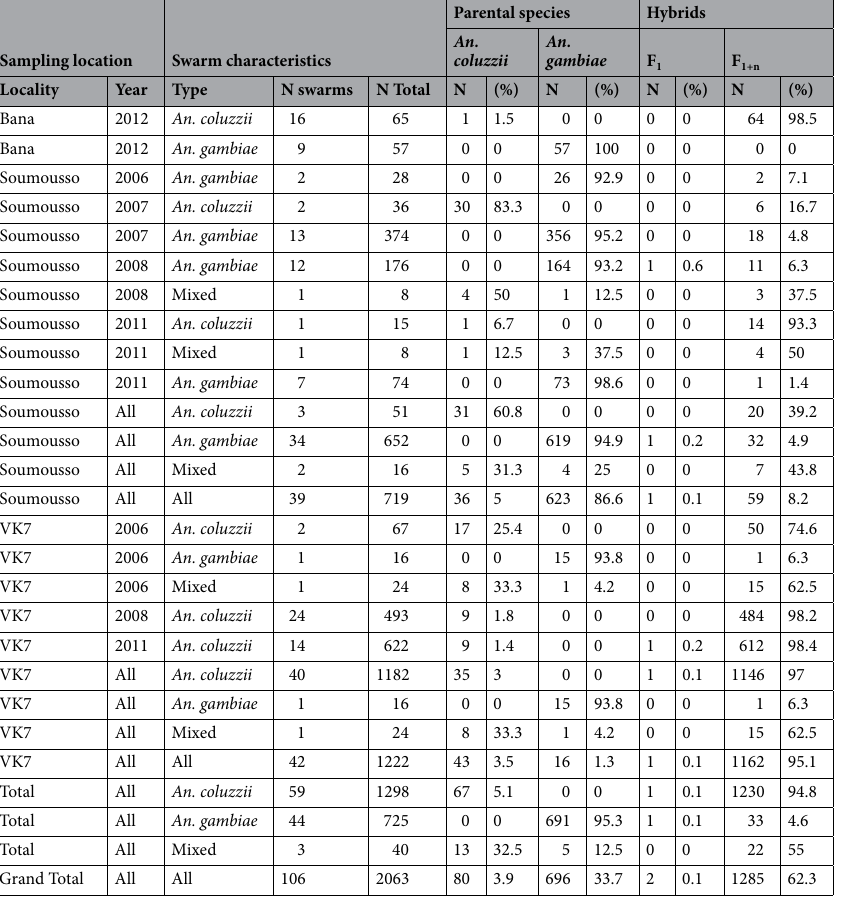
Table 1. Number and percentage of An. coluzzii and An. gambiae , and F 1 and F 1+n hybrid males from monospecific and mixed swarms. Swarms were collected from Bana (2012), Soumousso (2006, 2007, 2008 and 2011) and VK7 (2006, 2008 and 2011). The swarm type (monospecific An. coluzzii and An. gambiae s.s. or mixed with males of both species), number of swarms sampled, and total number of individuals genotyped are indicated. All means the total number of swarms per type or per village sampled during the period of the